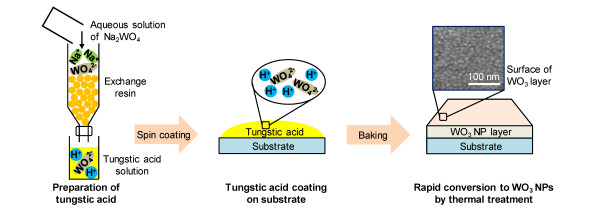
 Synthesis of WO3nanoparticles from aqueous solution of Na2WO4. Surface of WO3 layer was investigated through field emission scanning electron microscope (FESEM).